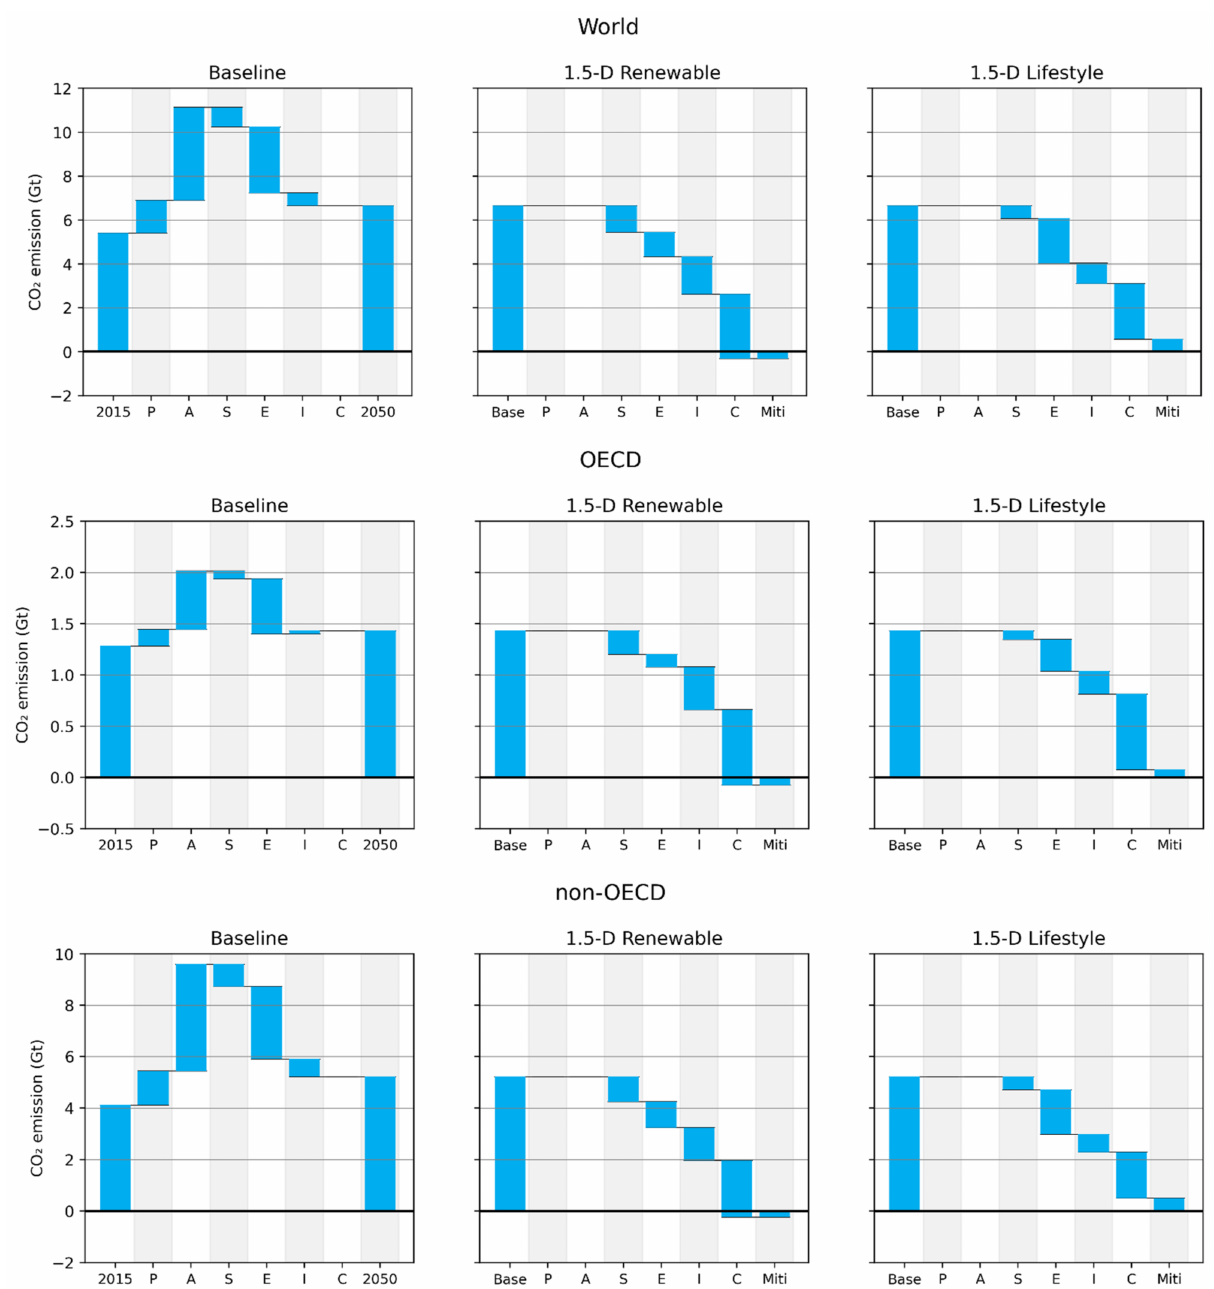
Figure 4. Changes in industry emissions between 2015 and 2050 (Baseline) and between Baseline and the mitigation scenarios (in 2050) due to different drivers. P: population growth, A: activity changes, S: electrification, E: efficiency, I: carbon intensity of non-renewable fuels, C: